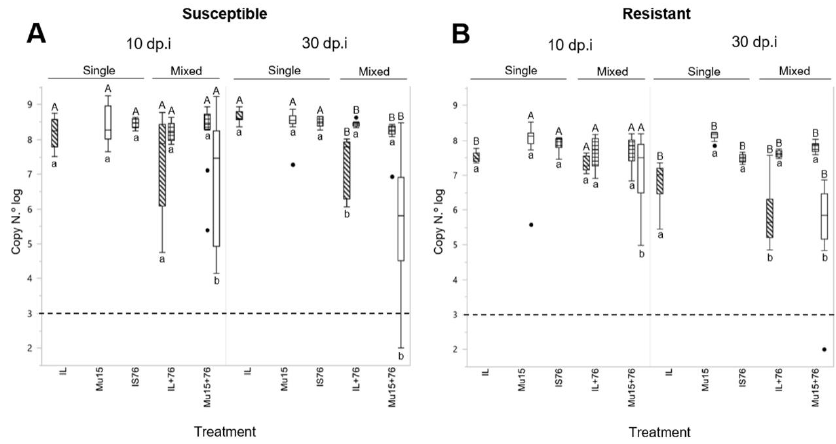
Figure 8. Viral DNA accumulation in susceptible ( A ) and resistant ( B ) plants at 10 and 30 dpi. DNA accumulation is expressed as the logarithm of the number of copies. Boxplot depicts the median line and delimits the 25 and 75% quantiles. Lines represent the range of values. Capital letters indicate significant differences (Kluskal–Wallis test, p < 0.05) in comparisons between single-infected viruses or between different viruses in mixed infections, where A represents no significant differences and B represent significant differences. Small letters indicate significant accumulation differences (Wilcoxon test, p < 0.05) in comparisons of the same virus between treatments, where a represent no significant differences and b represents significant differences. Boxplot patterns correspond to: White, Mu15 (TYLCV-Mu15); oblique lines, IL (TYLCV-IL); squares, IS76 (TYLCV-IS76). Agroinoculation treatments: single infection, Mu15 (clone TYLCV-Mu15), IL (clone TYLCV-IL), IS76 (clone TYLCV- IS76) and mixed infections Mu15 + IS76 (a mixture of TYLCV-Mu15 and TYLCV-IS76) and IL + IS76 (a mixture of TYLCV-IL and TYLCV-IS76).